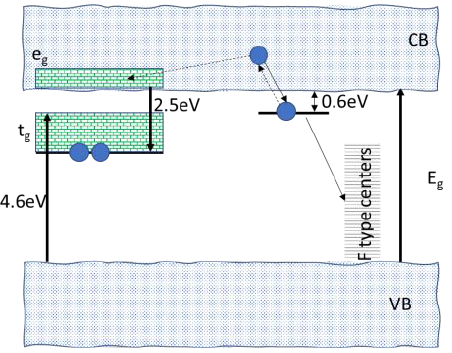
Figure 9. Characteristic luminescence spectra: ( a ) PL at an excitation wavelength of 325 nm; ( b ) CL at an accelerating voltage of 20 keV.